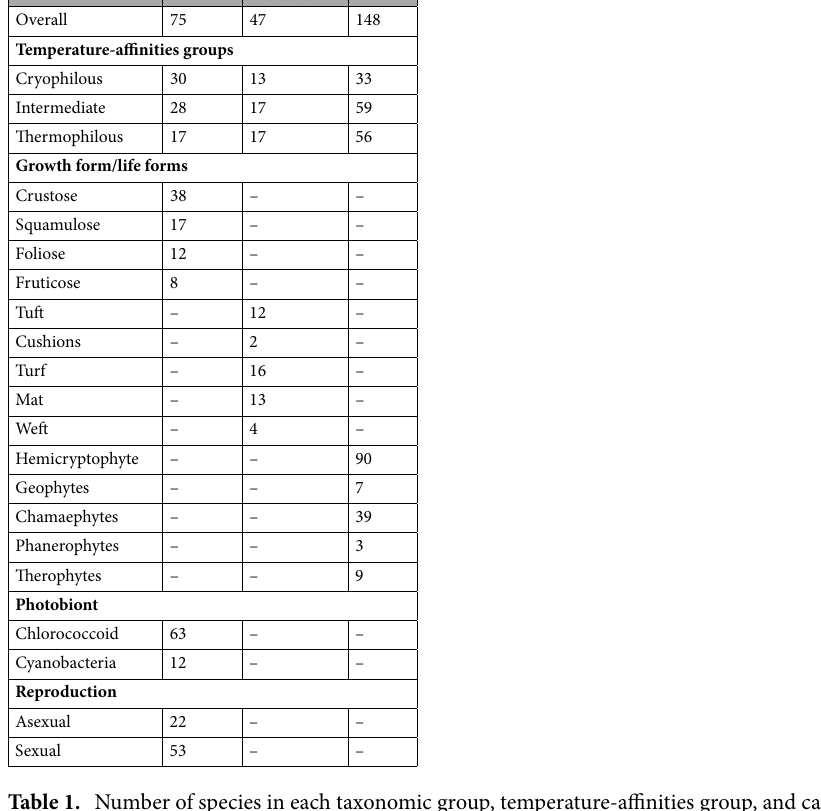
Table 1. Number of species in each taxonomic group, temperature-affinities group, and categorical functional